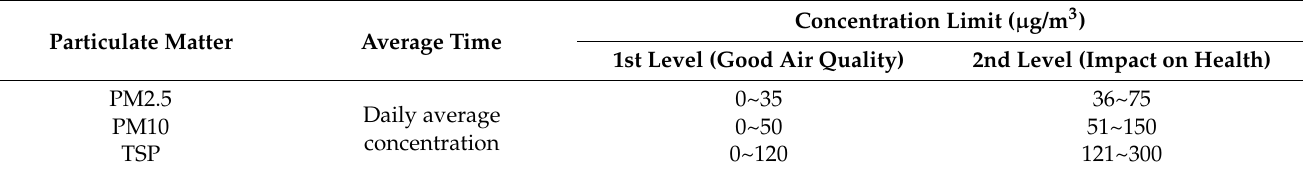
Table 8. Limits of the daily average of particulate matter